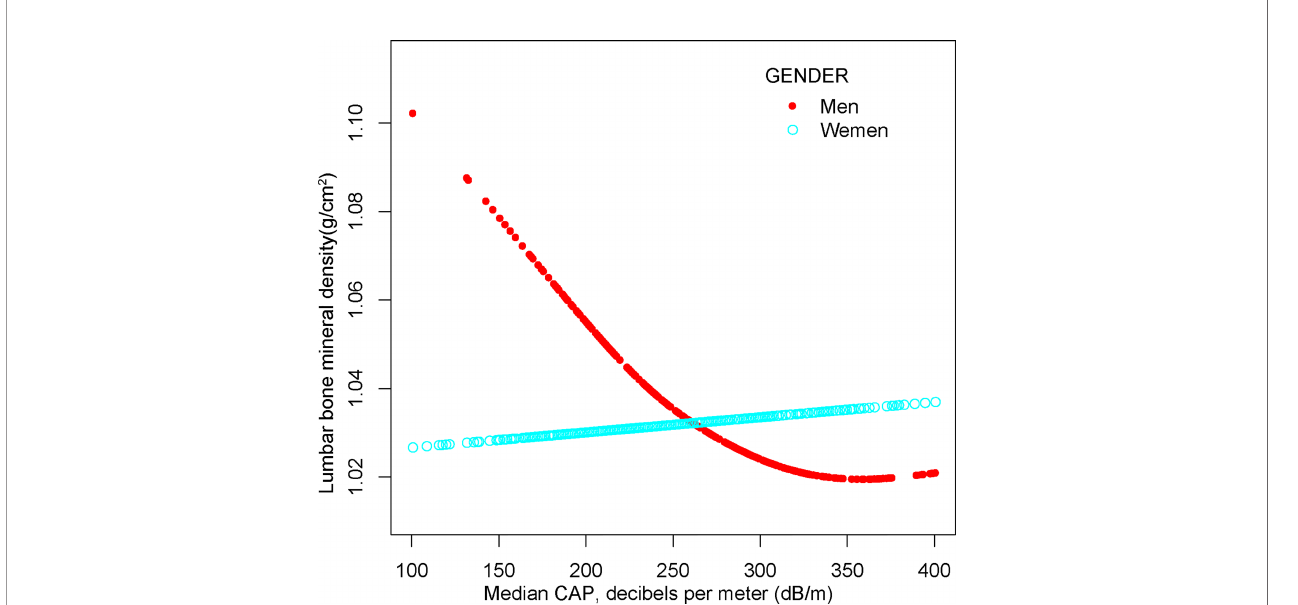
FIGURE 3 | The association between NAFLD and lumbar bone mineral density strati fi ed by gender. Age, gender, race, body mass index, poverty to income ratio, education, diabetes status, waist circumference, Glycated hemoglobin, Total cholesterol, Triglyceride, LDL- cholesterol, HDL- cholesterol, ALT, ALP, GGT, AST, Serum creatinine, Serum iron, Lumbar bone mineral density, CAP and LSM were